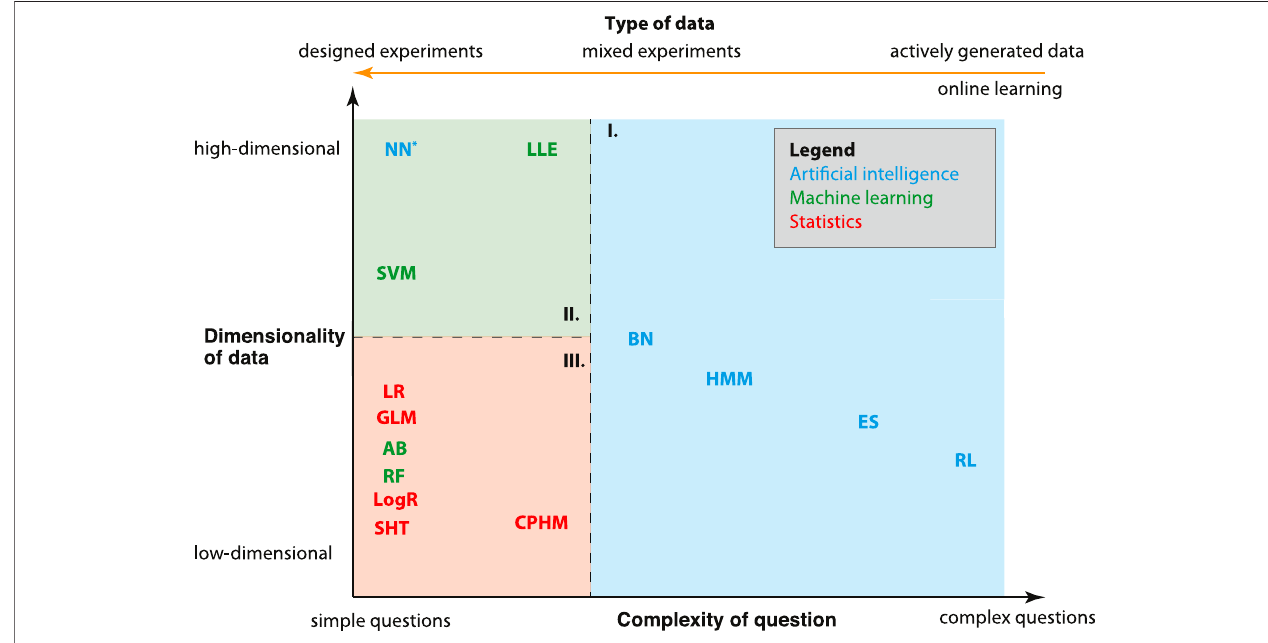
FIGURE1 | Asimpli fi ed, graphical overview ofproperties ofcore(and base)methods from arti fi cial intelligence(AI),machine learning (ML) and statistics.The x -axis indicates simple (left) and complex (right) questions a method can study whereas the y -axis indicates low- and high-dimensional methods. In addition, there is an orangeaxis (top) indicatingdifferentdata-types.Overall,onecandistinguishthreeregionswhereeithermethodsfromarti fi cialintelligence(blue),machinelearning(green) or statistics (red) dominate. See Table 1 for acronyms.